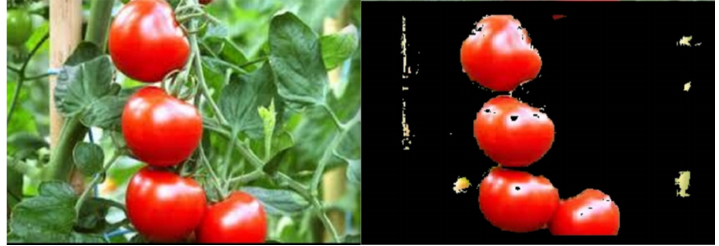
Figure 9. Results of the prediction of the trained neural network with no